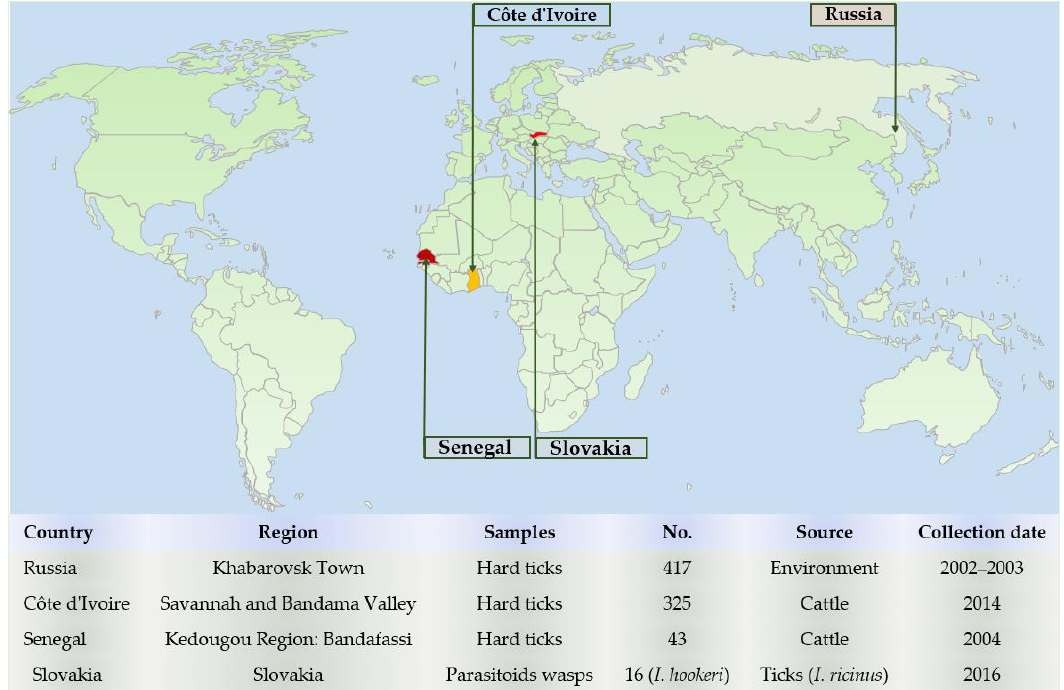
Figure 1. Map showing the type, origin, period, and number of samples collected in Africa and the Russian Far East.